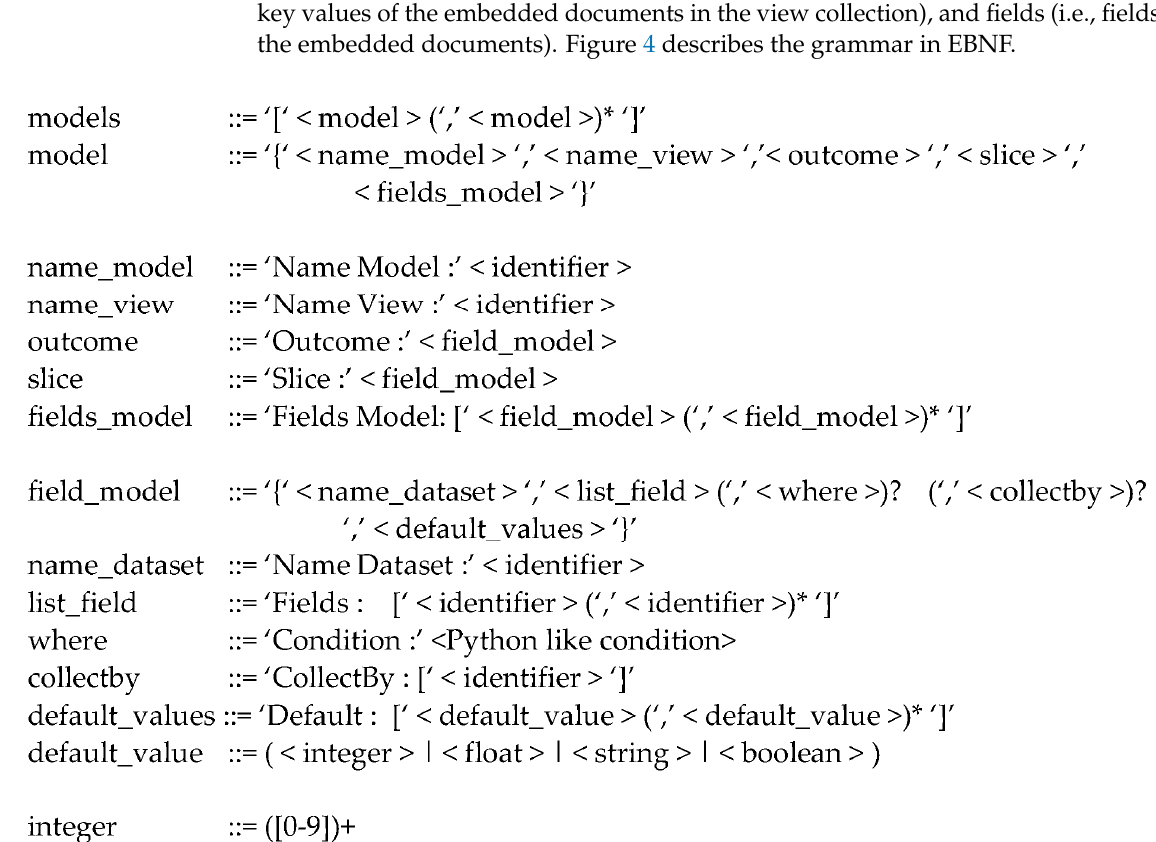
Figure 4. EBNF for the query language for the model creation process.